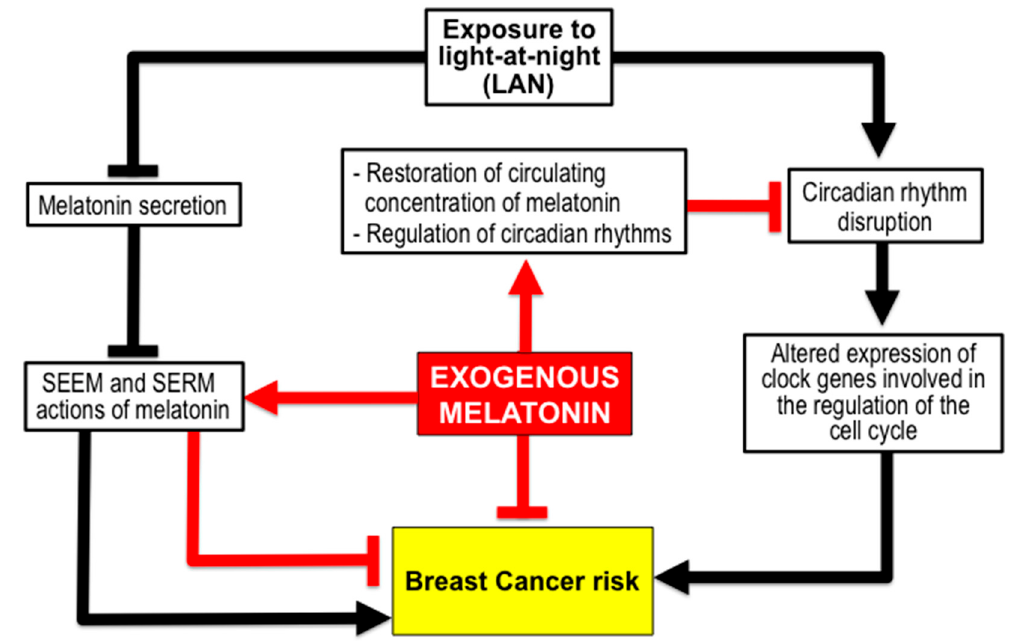
Figure 3. The administration of melatonin could reduce the breast cancer risk associated with chronodisruption caused by exposure to light at night, such as occurs in nocturnal shift workers. The exogenous melatonin restores the decreased circulating levels of the endogenous hormone,